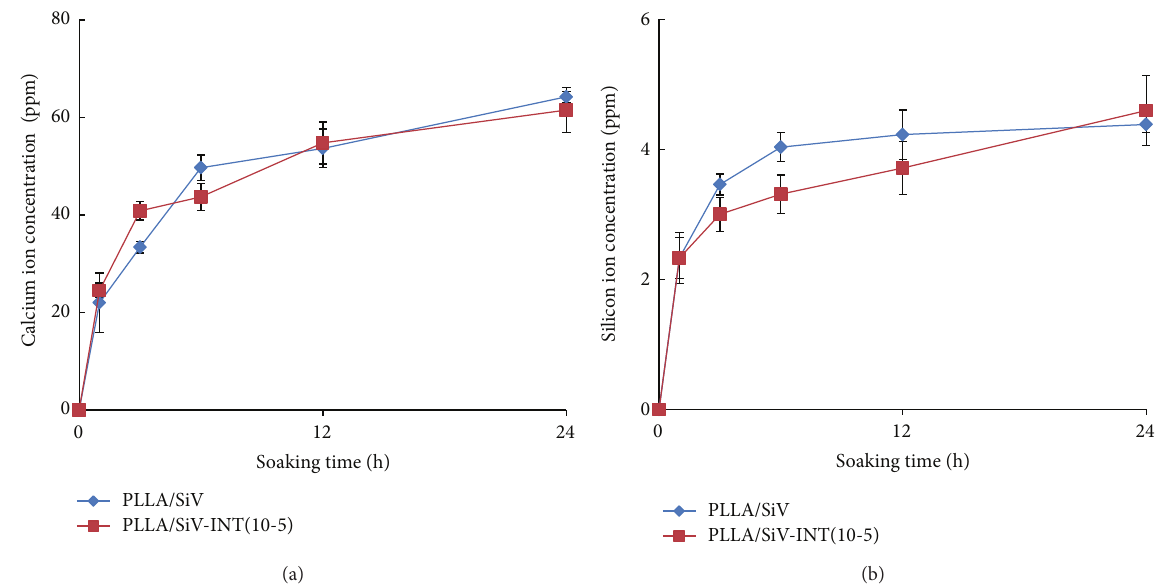
Figure 2: (a) Calcium and (b) silicon amounts released from PLLA/SiV and PLLA/SiV-INT(10-5) after soaking in Tris buffer solution. Circle: PLLA/SiV, diamond: PLLA/SiV-INT(10-5).